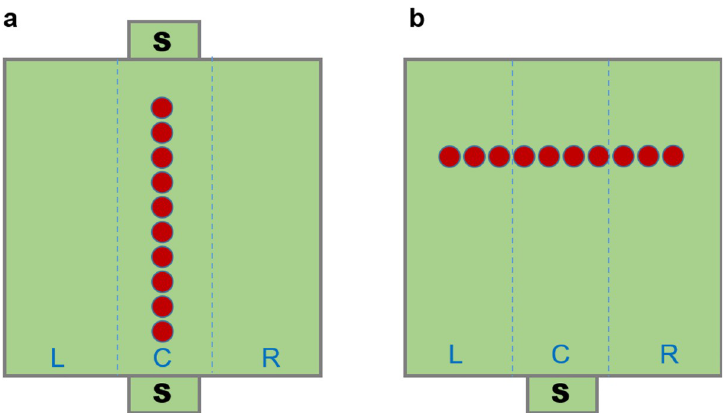
Fig 1. Schematic illustration of the apparatus and the series of elements. S represents the starting box. In light blue the three sectors used to evaluate the direction of approach to the series: L, left; C, central or R, right. (a) The position of the series during training, retraining and sagittal test, with two possible starting positions. (b) The displacement of the series for the fronto-parallel tests.